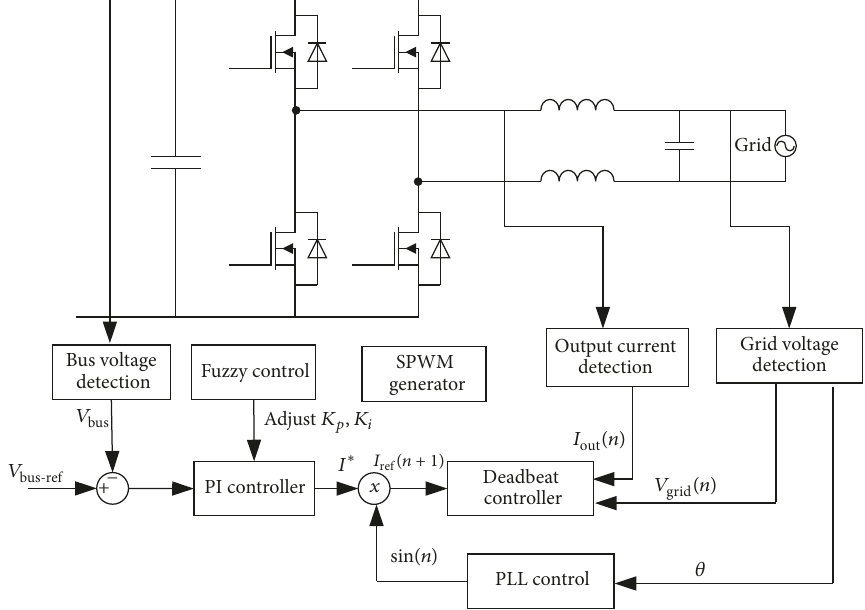
Figure 7: Control strategy chart for poststage inversion of grid-connected operating